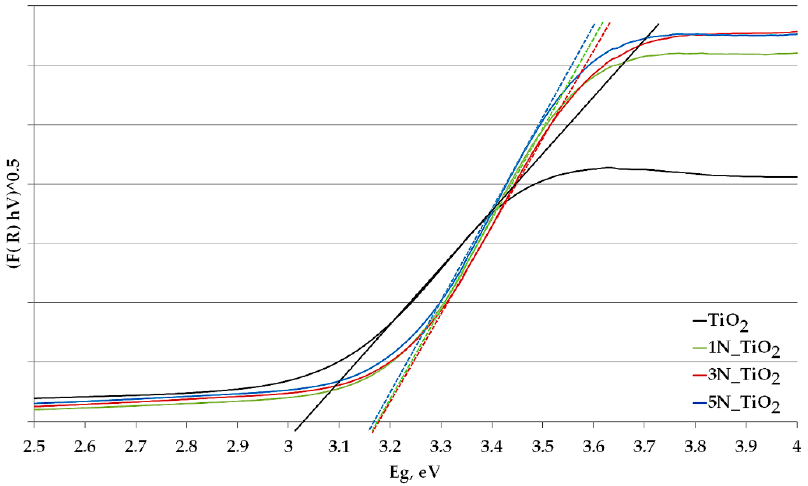
Figure 3. Tauc plots presenting the graphical band gap energy calculation.